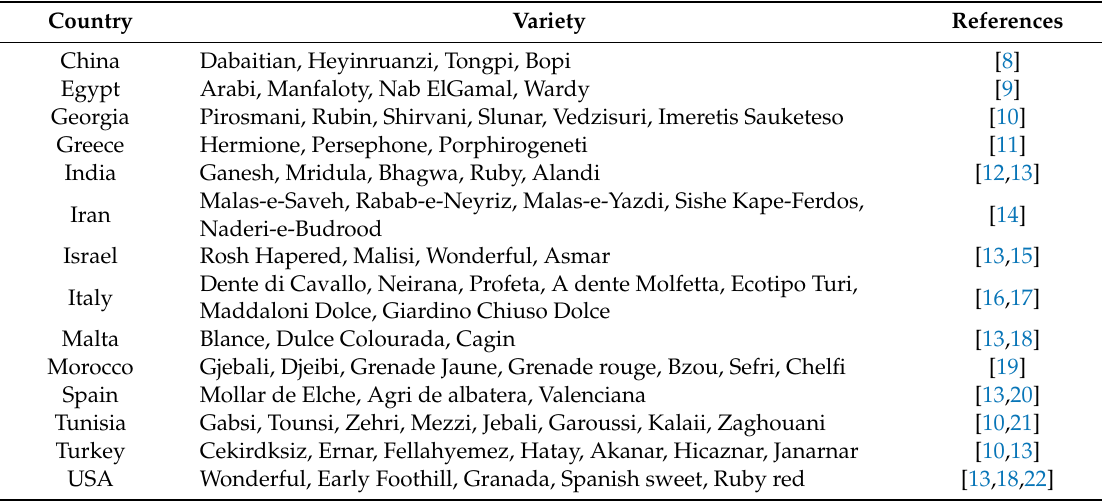
Table 1. Some of the pomegranate varieties around the